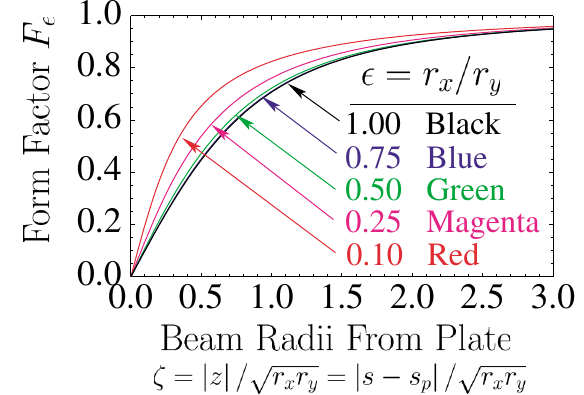
FIG. 8. (Color) Form factor F beam envelope equations (34) plotted versus , (cid:1) j z j = (cid:1)(cid:1)(cid:1)(cid:1)(cid:1)(cid:1)(cid:1)(cid:1)(cid:1) r p j = (cid:1)(cid:1)(cid:1)(cid:1)(cid:1)(cid:1)(cid:1)(cid:1)(cid:1) r j s (cid:2) s r for values of (cid:18) (cid:1) r p x y